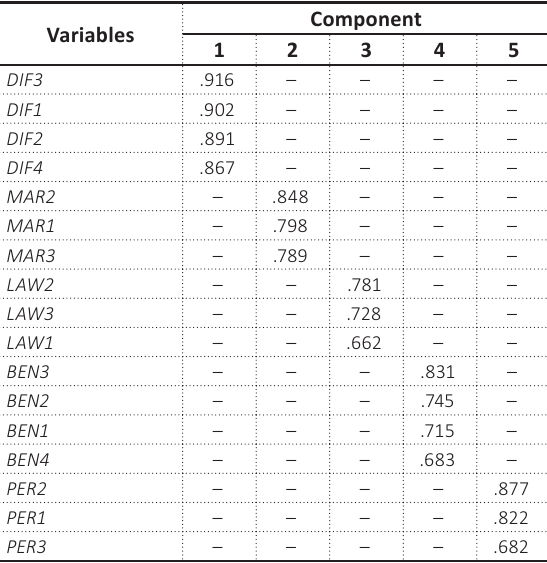
Table 6. Rotated component matrix